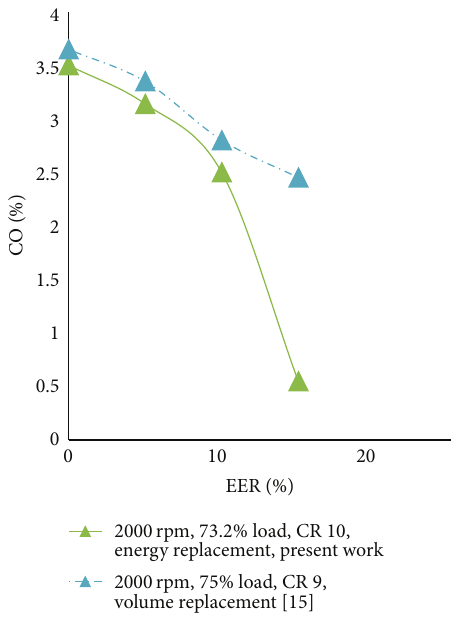
Figure 15: Comparison of present results with results of [15].